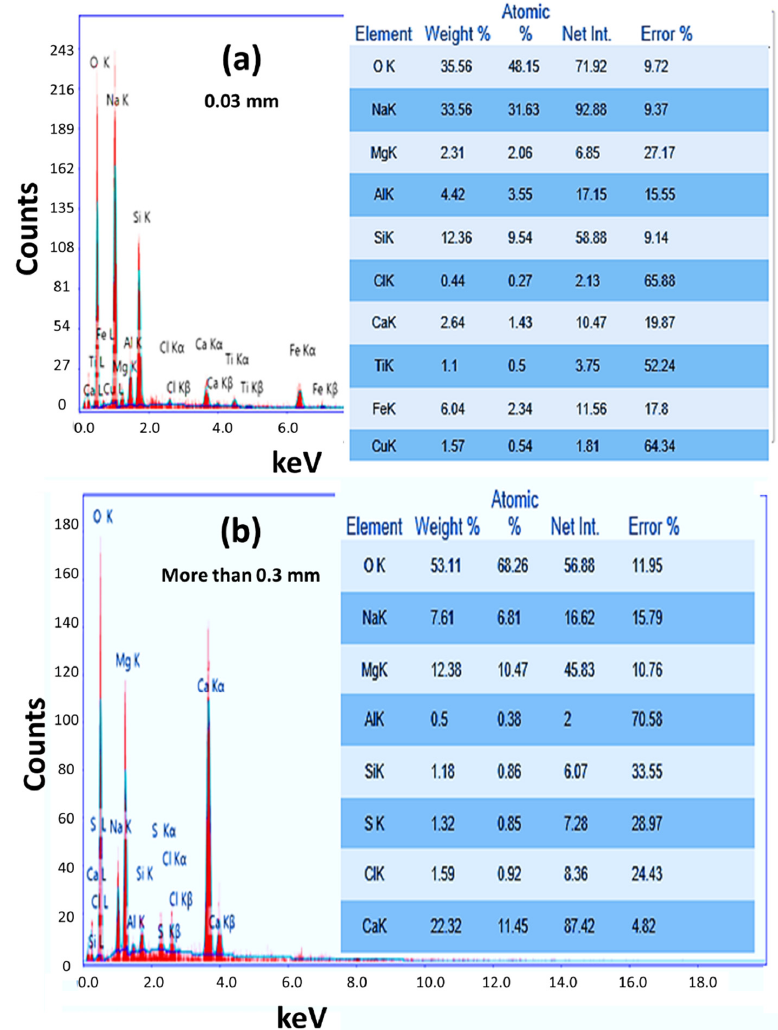
Figure 2. EDX patterns for nanostructured ( a ) RW 0.03 and ( b ) RW >0.3